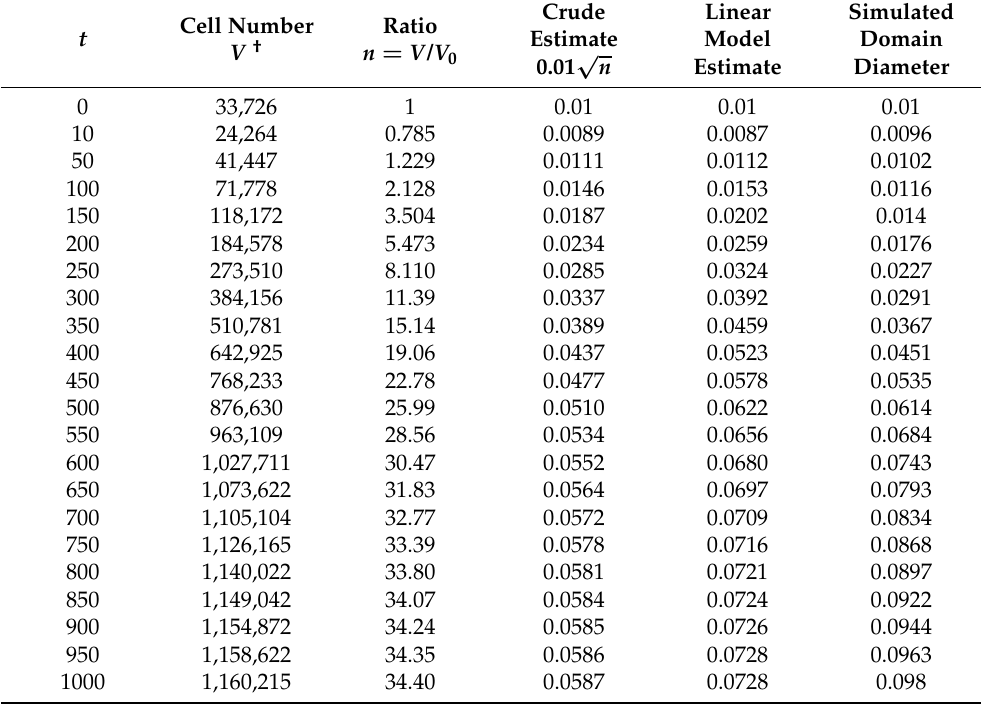
Table 3. The total number of cells V , the ratios n = V / V 0 , the crude estimate of diameters 0.01 the linear model’s prediction of diameters, and the diameter of the domain after we apply the solid displacement vector u , at different